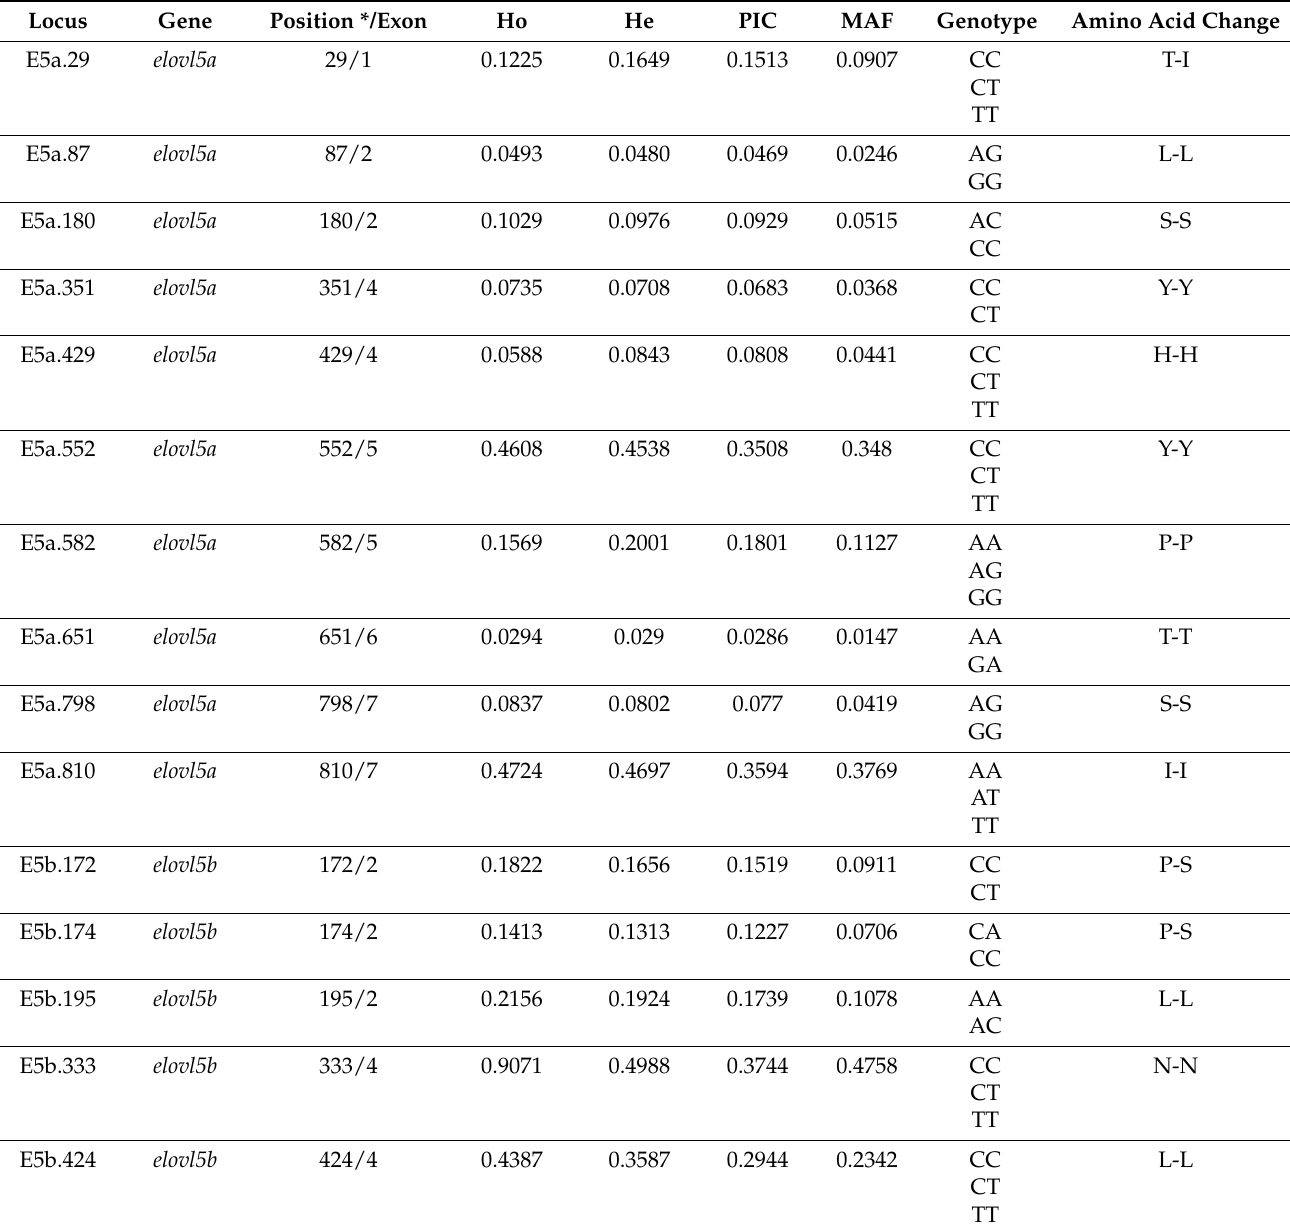
Table 1. Genetic diversities of SNPs in the coding sequences of elovl5a and elovl5b